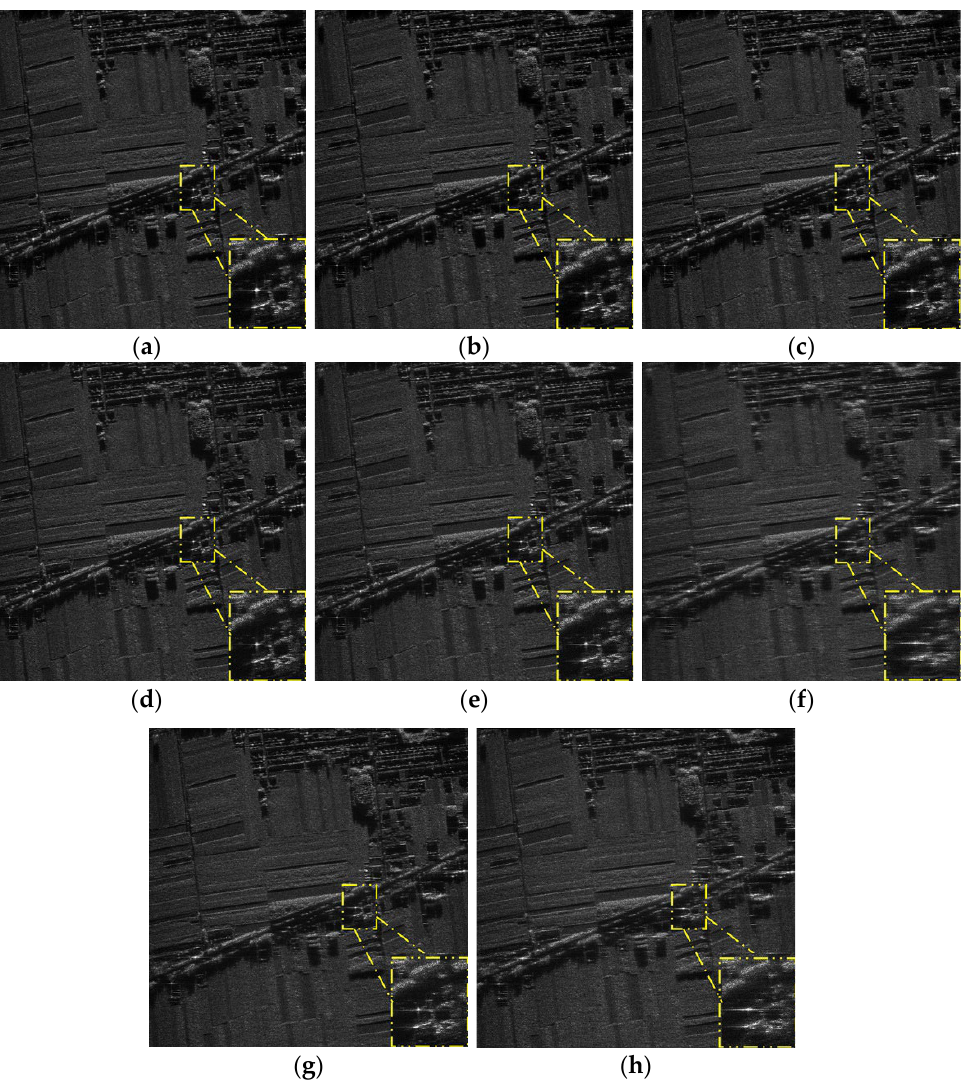
Figure 13. Imaging results with experimental data. ( a ) BP-CPU-FP64; ( b ) FBP-CPU-FP64; ( c ) FFBP-CPU-FP64; ( d ) BP-GPU-FP32; ( e ) FBP-GPU-FP32; ( f ) FFBP-GPU-FP32; ( g ) BP-GPU-FP16; ( h ) FBP-GPU-FP16.